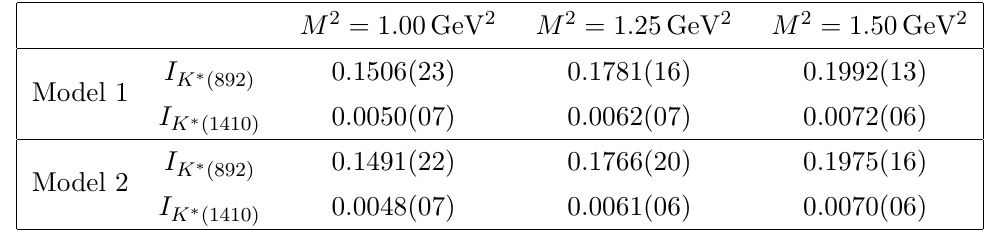
Table 8 . Values for the quantities I R for R = f K (cid:3) (892) ; K (cid:3) (1410) g for the di(cid:11)erent values of the Borel parameter M 2 and for the two models for the K(cid:25) form factor. The K (cid:3) (1410) contribution is very suppressed in the sum rules, with I